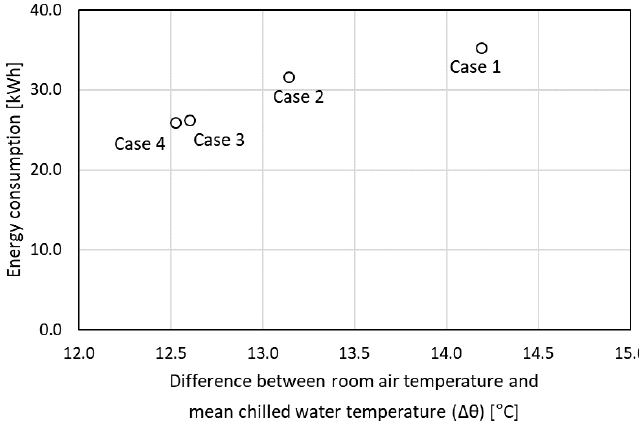
Figure 10. Relationship between Δθ and energy